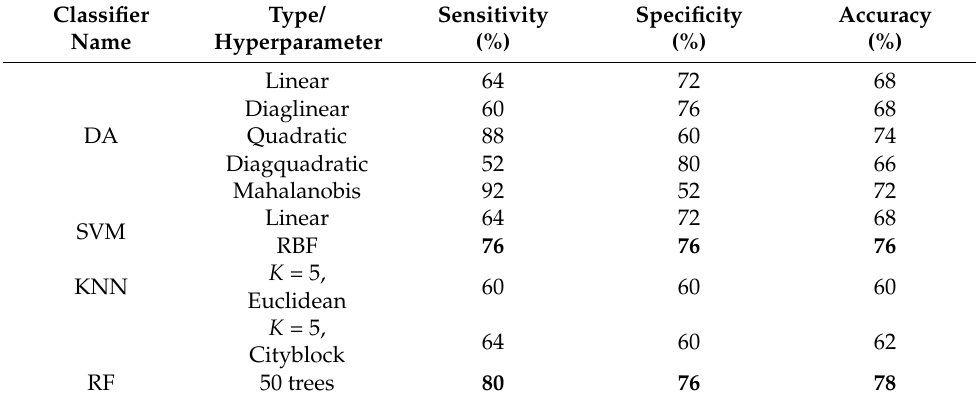
Table 1. Performance comparison of different